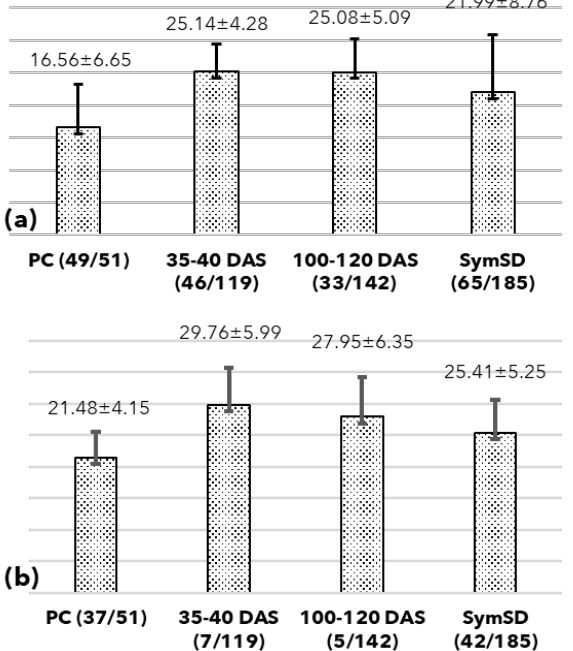
Figure 4. Range of Ct Values in samples screened using nested qPCR ( a ) and qPCR using genomic DNA template ( b ). Range of Ct values in positive control samples (PC), Seedlings collected at 35–40 DAS, Seedlings collected at 100–120 DAS, and seeds collected from SSD symptomatic sandalwood trees (SymSD). The figures in the parenthesis indicate the number of samples that tested positive for phytoplasma and the total number of samples screened.